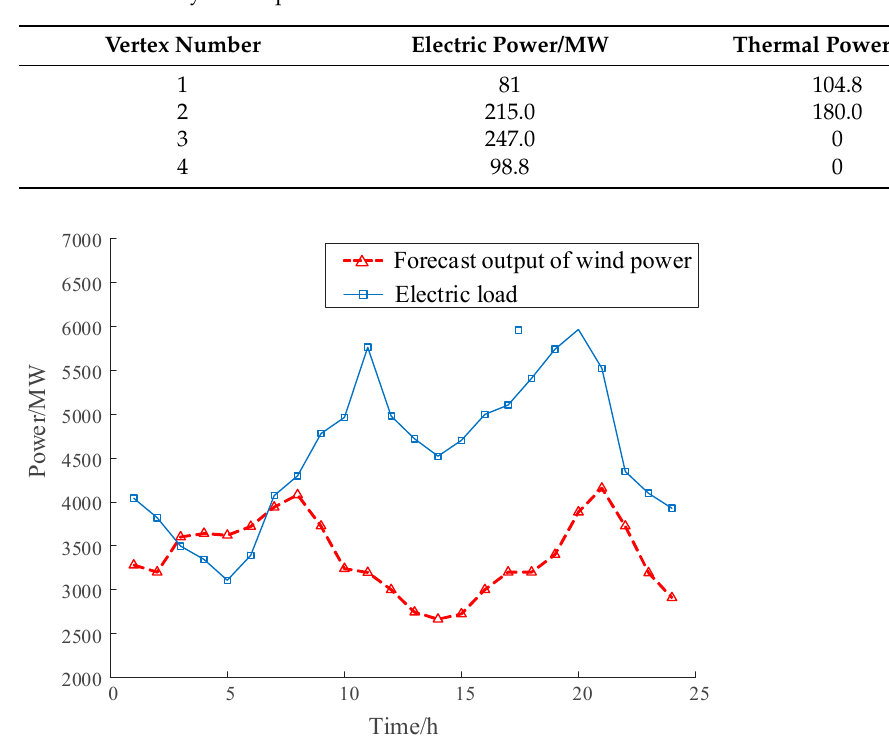
Figure 4. Electric–gas–heat integrated energy system structure diagram. Table 1. Boundary vertex parameter of CHP.